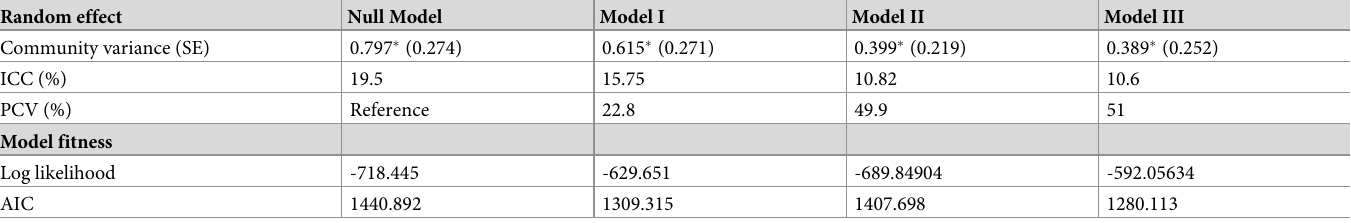
Table 1. Random effects and model fitness of individual and community-level factors associated with optimal breastfeeding among 0-5-month-old children, Ethio- pia